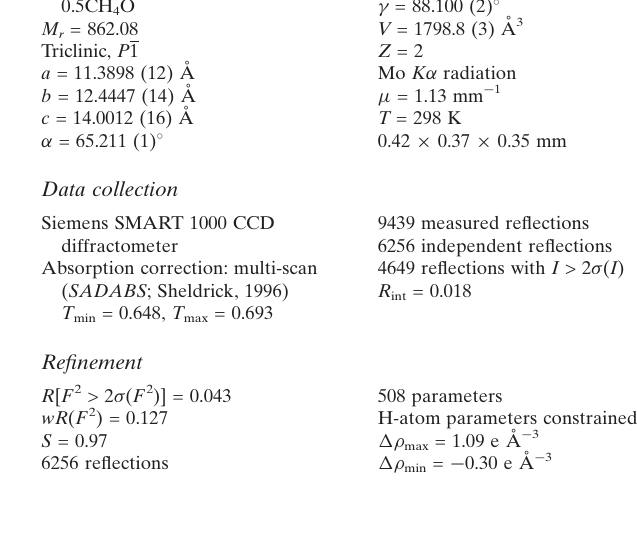
parameter ratio = 12.3.